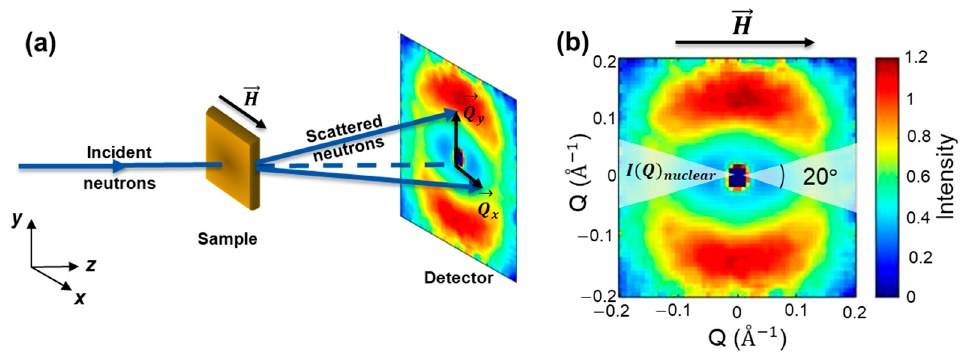
Figure 2. ( a ) Schematic of SANS technique; ( b ) illustration of the separation of the nuclear scattering obtained from 20 ◦ sectors ( Ψ = − 10 ◦ to + 10 ◦ ) parallel to the magnetic field (applied along the axis). x